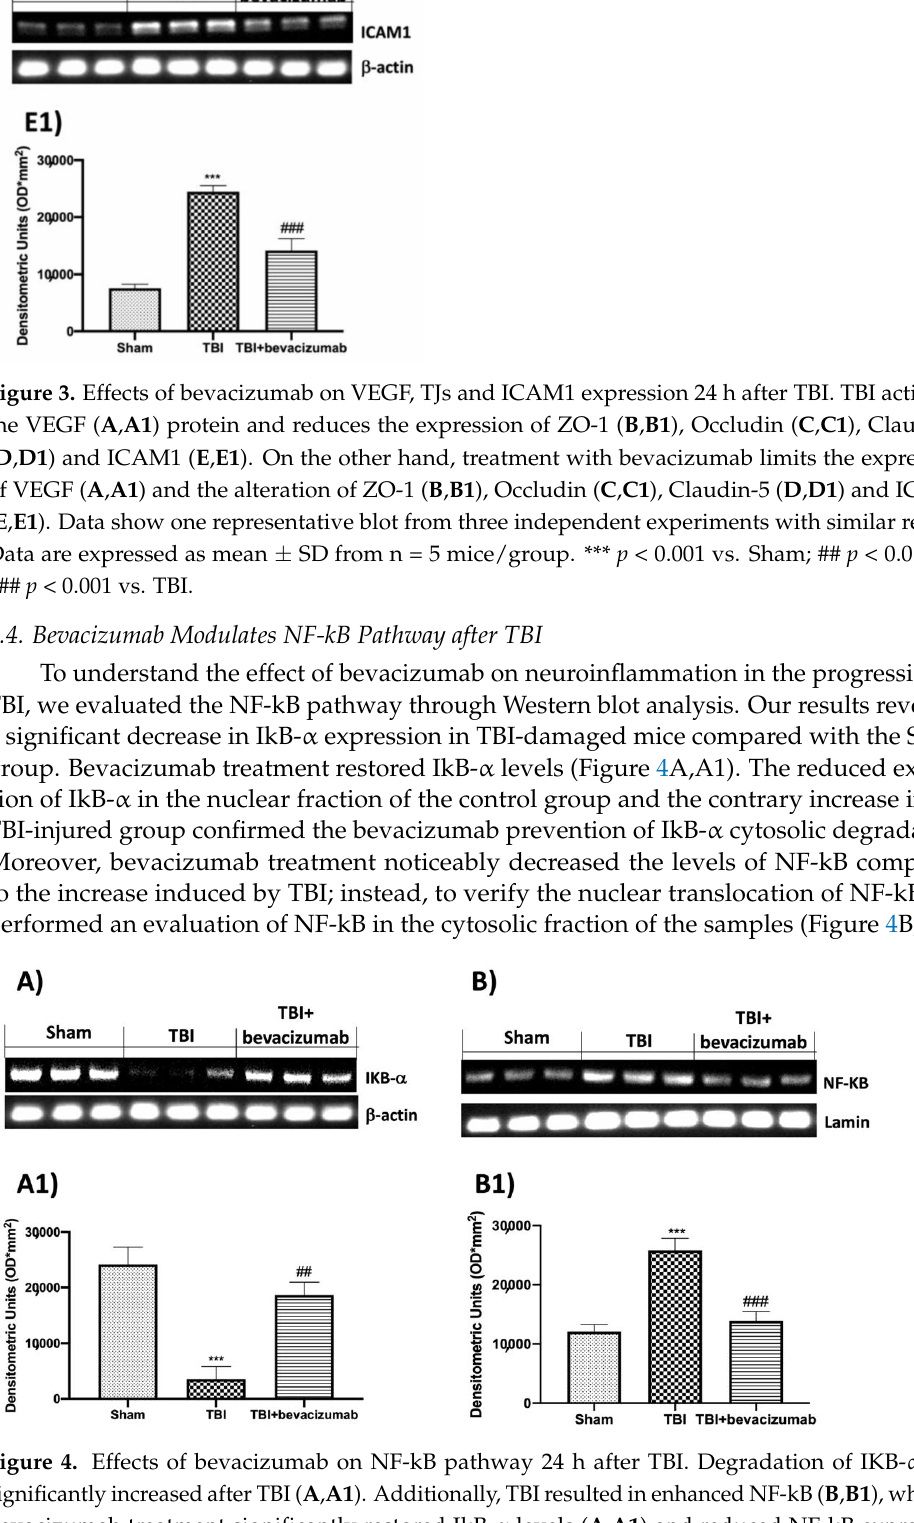
Figure 4 . Effects of bevacizumab on NF-kB pathway 24 h after TBI. Degradation of IKB-α was sig- Figure 4. Effects of bevacizumab on NF-kB pathway 24 h after TBI. Degradation of IKB- significantly increased after TBI ( A , A1 ). Additionally, TBI resulted in enhanced NF-kB ( B , B1 ), whereas bevacizumab treatment significantly restored IkB- α levels ( A , A1 ) and reduced NF-kB expression ( B , B1 ). Data show one representative blot from three independent experiments with similar results. Data are expressed as mean ± SD from n = 5 mice/group. *** p < 0.001 vs. Sham; ## p < 0.01 and ### p < 0.001 vs.